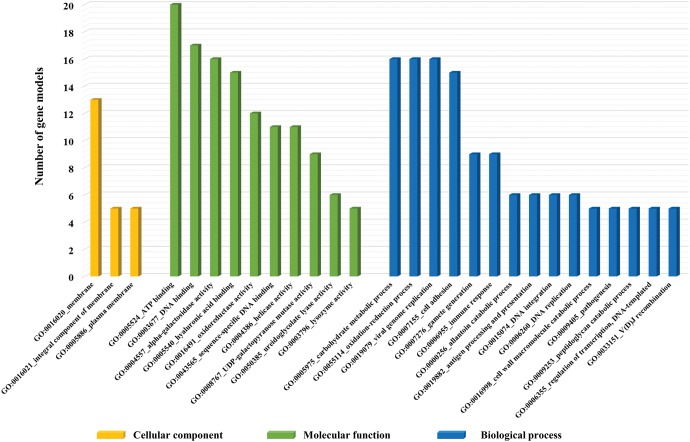
Gene ontology (GO) categories of unique gene families in R. philippinarum among four Mollusca. The functions of 68 gene families were classified and subdivided into a total of 93 GO terms. However, the majority of gene families is only represented in this figure as follows three main categories: Cellular components (yellow), molecular function (green), and biological process (blue). The x axis denoted the related functional categories and the y axis denoted the number of gene models, which are associated with each GO categories.